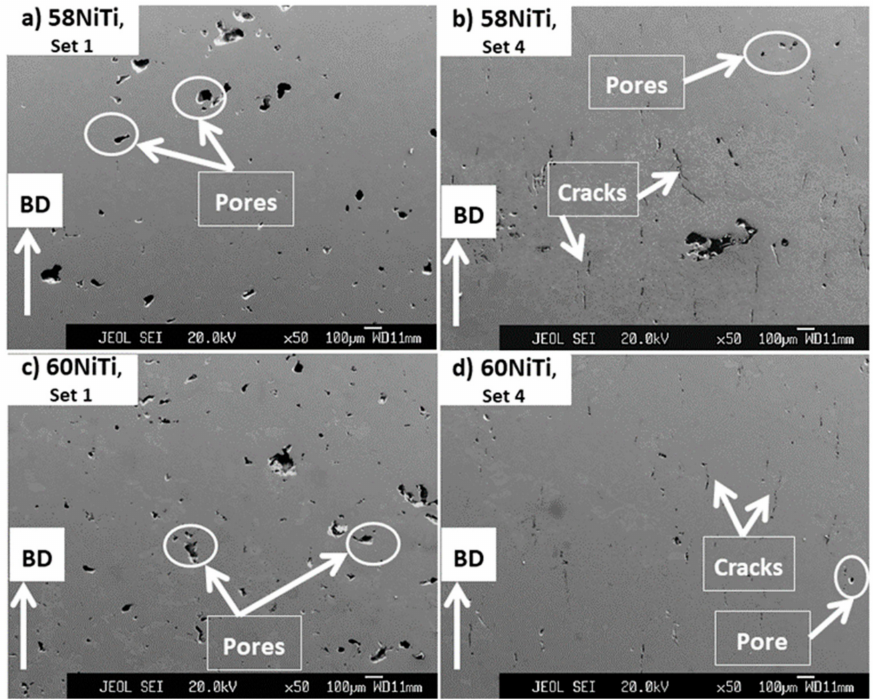
Figure 9. Images obtained from the cross-section of ( a , b ) 58NiTi and ( c , d ) 60NiTi samples processed by elementary HIP treatments from parts printed by sets 1 and 4 having energy inputs of 27.70 and 39.68 J/mm 3 , respectively. Some of the cracks and pores seen in the microstructure of these samples are shown in the